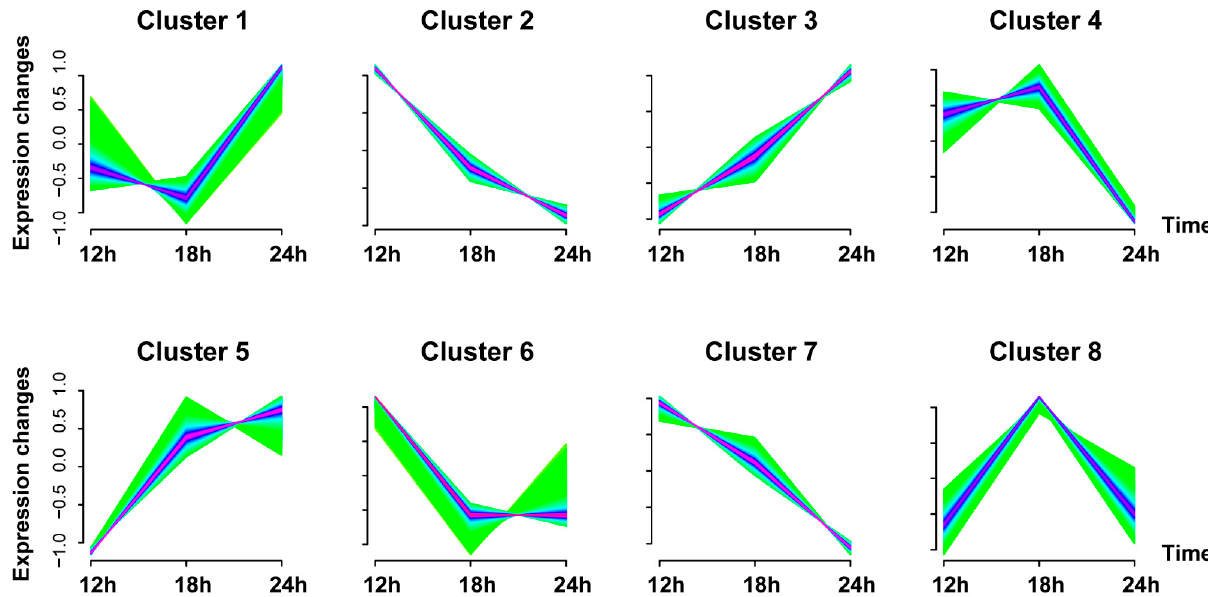
Figure 2. Graphs of eight clusters in SADS-CoV-infected Vero E6 cells along time series based on FPKM value of genes at 12, 18, and 24 hpi. Genes in the same cluster have a similar expression trend. Viruses 2021 , 13 , x FOR PEER REVIEW